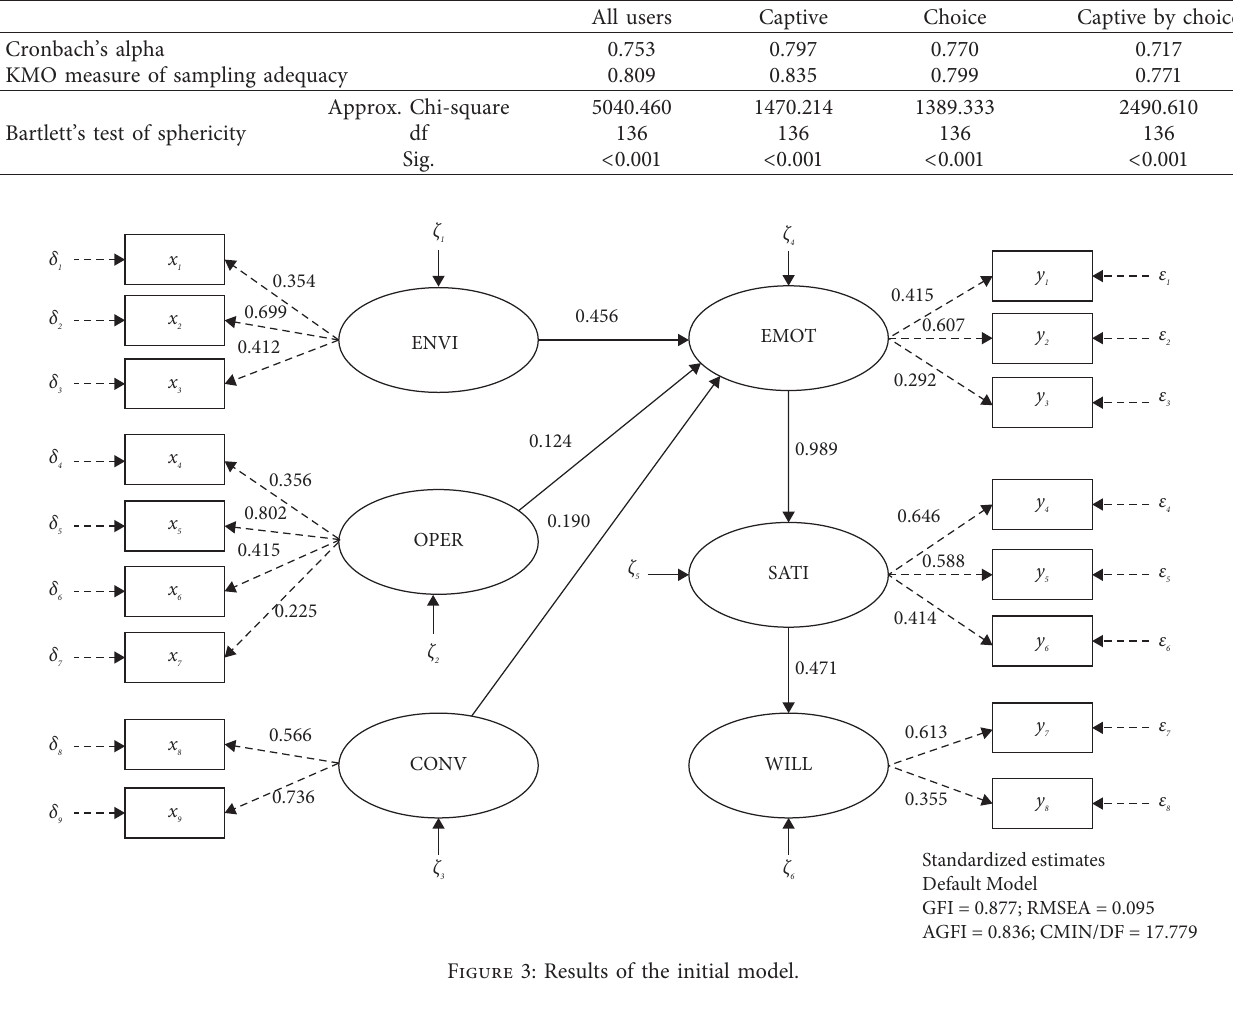
Table 5: Data reliability and validity.